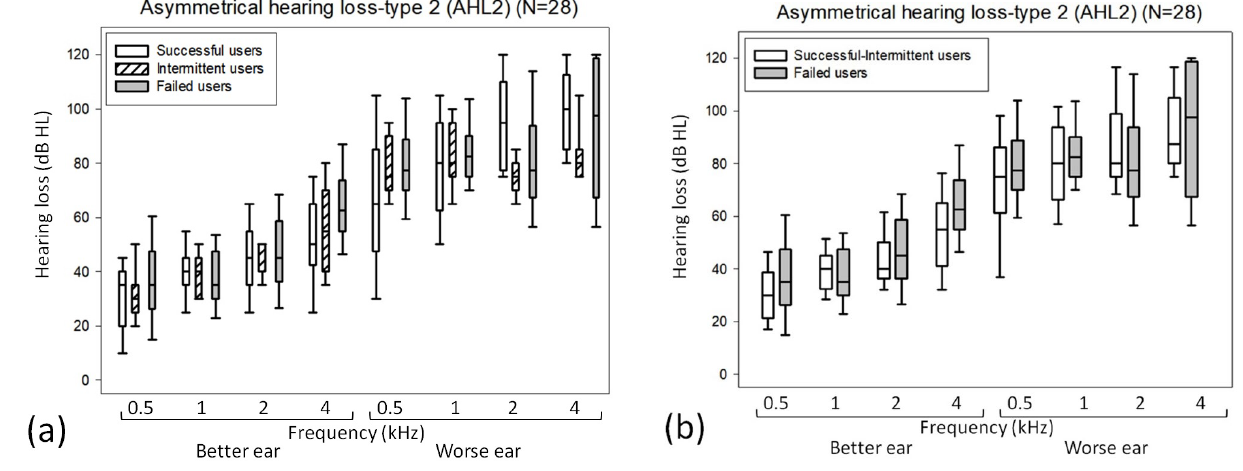
Figure 4. ( a , b ) Box plots of differences in the hearing thresholds according to ( a ) three and ( b ) two outcomes for the AHL2 subgroup (n = 28).